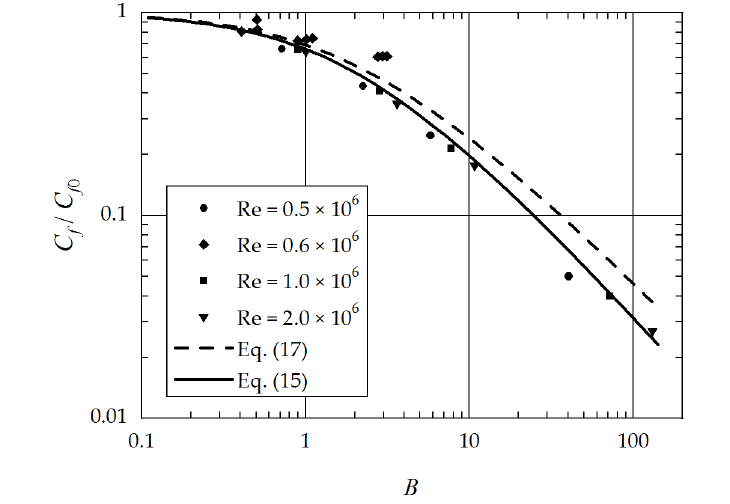
Figure 2. Comparison of blowing correction formulations expressed over a range of blowing parameters at several Reynolds numbers. Data taken from